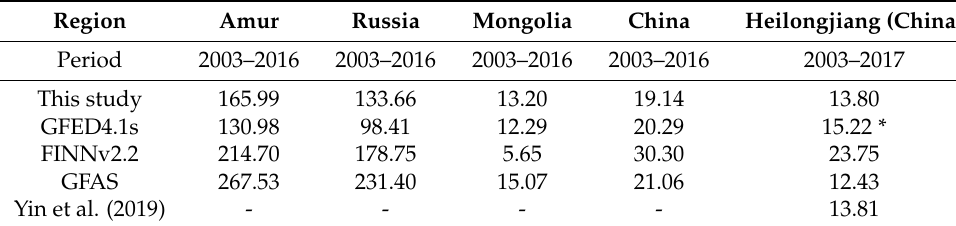
Table 5. Comparison of annual mean CO 2 emissions from biomass burning (Tg) calculated in our study with estimates made by other methods. (Unit: Tg).